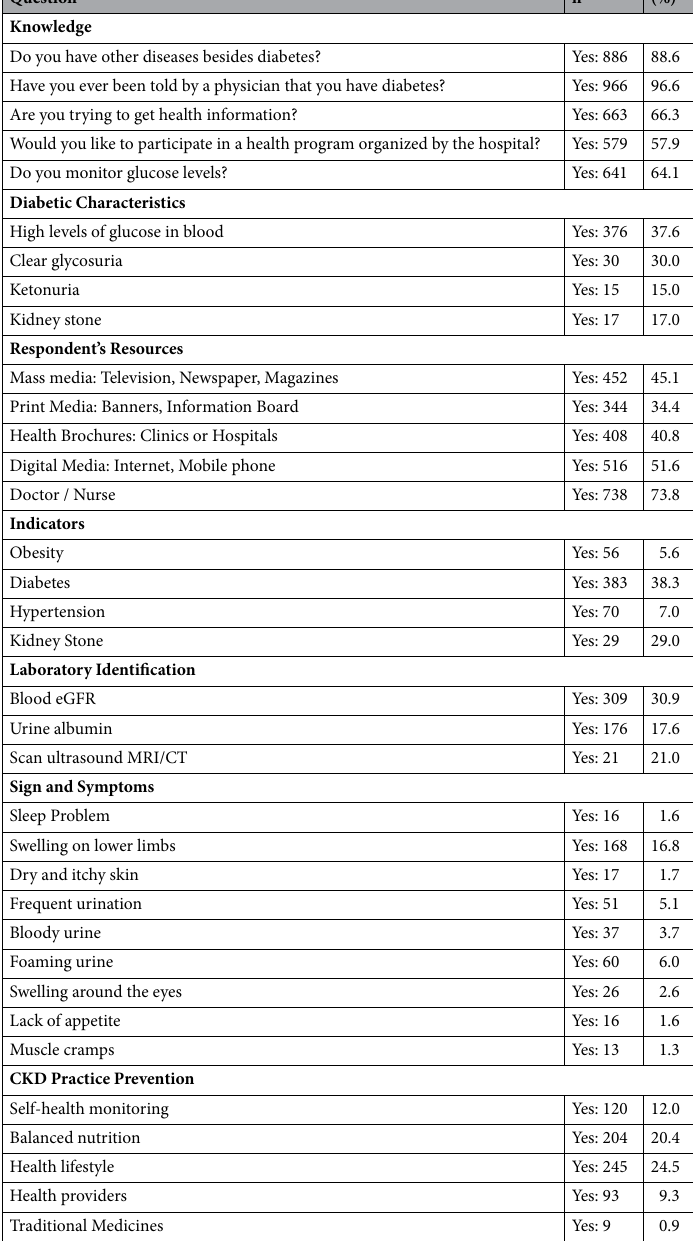
Table 2. Predictors on general knowledge of